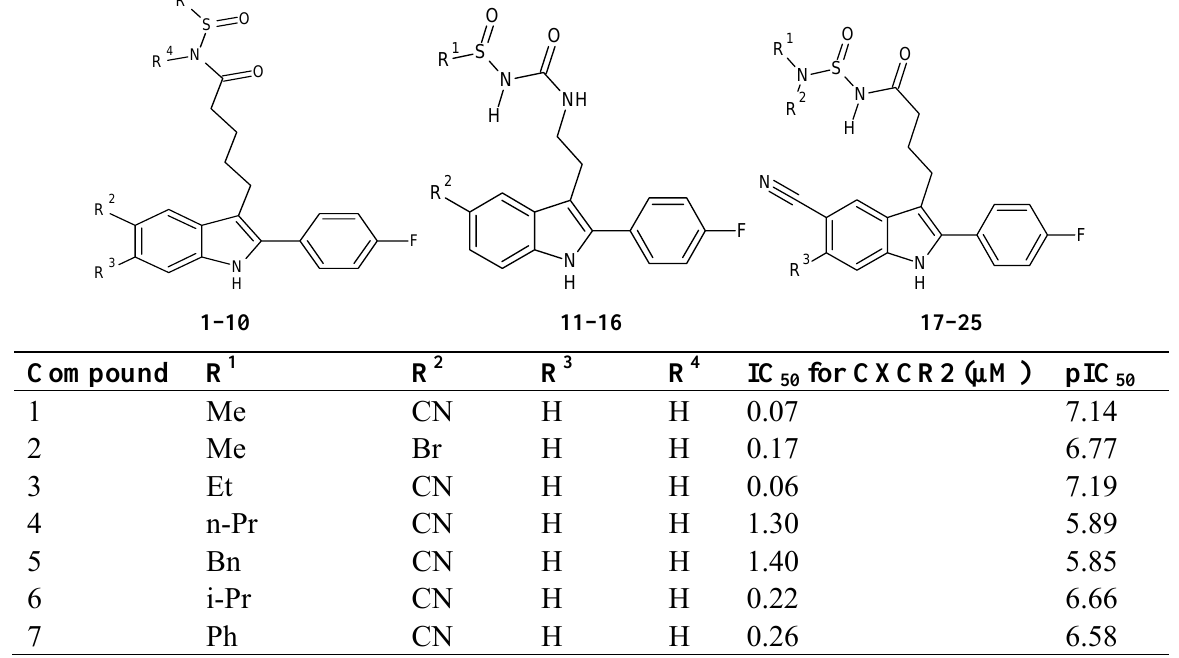
Table 1. Structures and biological activities of the acylsulfonamide